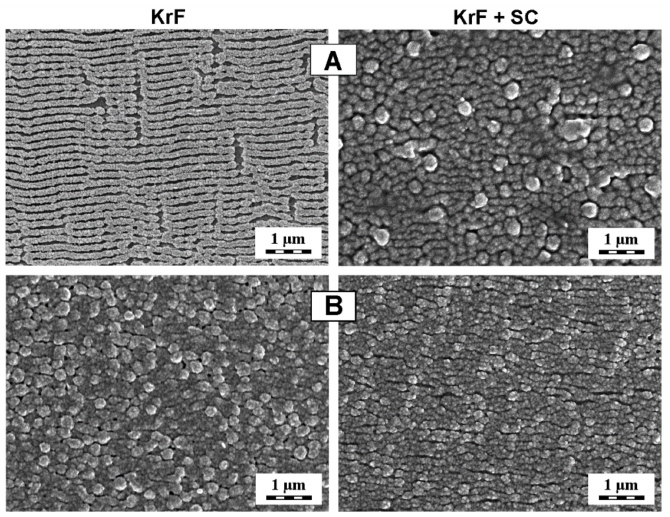
Figure 7. FEGSEM micrographs showing the difference between the surfaces of PET ( A ) and PEEK ( B ) after optomechanical processing of AgNPs (KrF), and subsequent irradiation using SC laser (KrF +